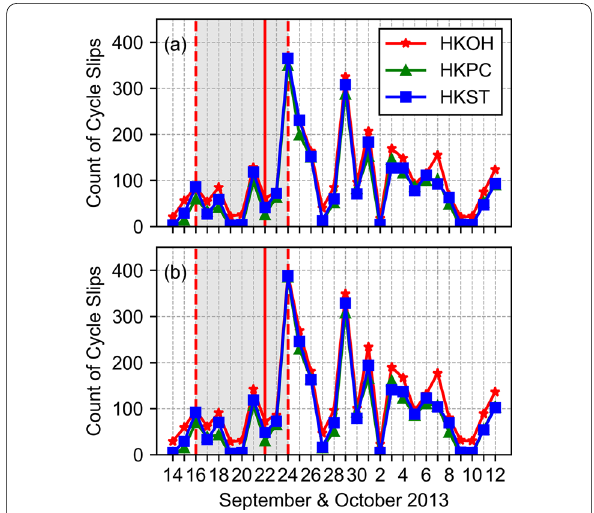
Fig. 7 Count of cycle slips calculated from the HKOH (red line with stars), HKPC (green line with triangles), and HKST (blue line with squares) stations from 14 September to 12 October 2013 on the GPS L1 ( a ) and L2 ( b ) signals. The life cycle of the Usagi was from 16 to 24 September 2013, as represented by the gray background area between two vertical red dashed lines. The vertical red solid line denotes the TC’s landfall near Hong Kong on 22 September